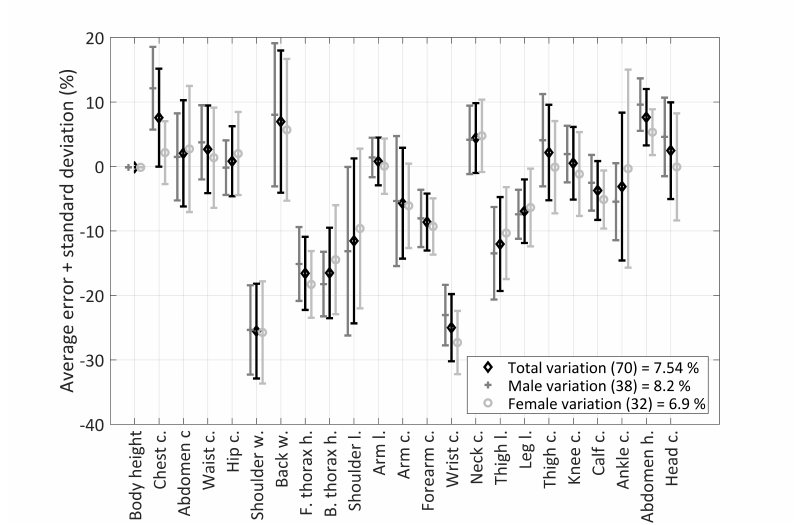
Figure 4. Czech adults. Average variations and the standard deviations.